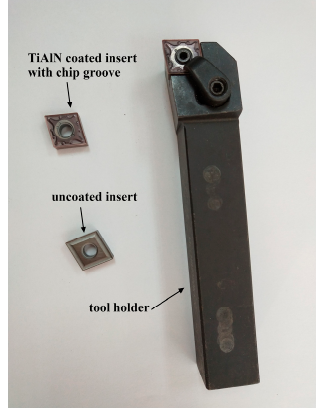
Figure 2. Two inserts and tool holder.